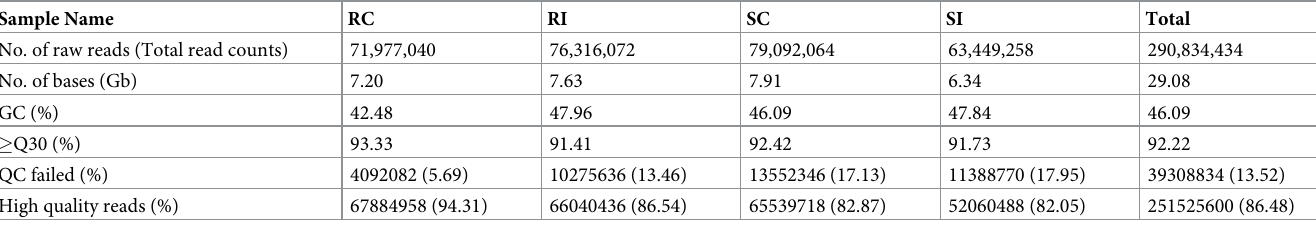
Table 1. Statistics of transcriptome sequencing in resistant and susceptible genotypic combinations under infected and control conditions.